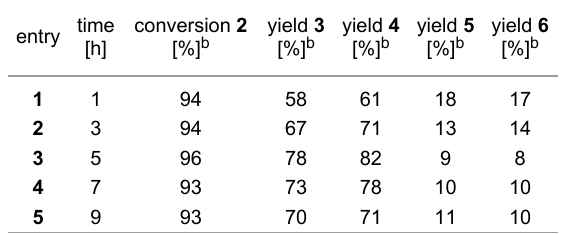
Table 4: Results of variation of the reaction time of cross-metathesis of 1 with 2 . a